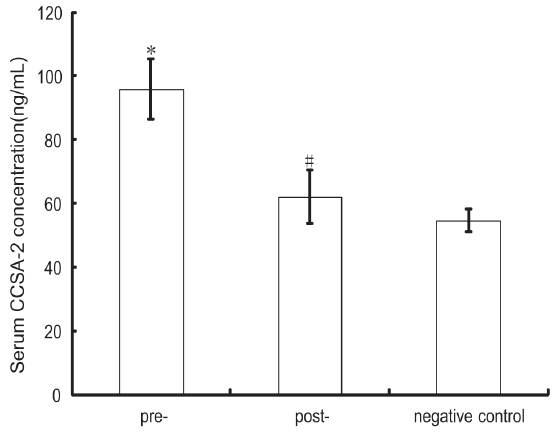
Figure 2. Pre- and post-operative levels of serum CCSA-2 in colorectal cancer patients. *, # : Statistic analysis showed the serum CCSA-2 concentration decreased significantly after surgery, but is still higher than the level of negative control ( F =827.57, P ,